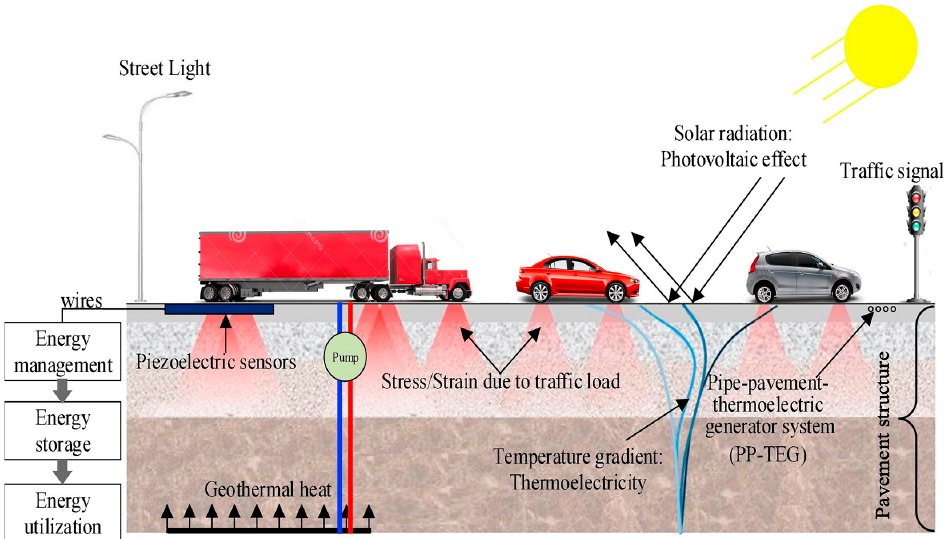
Figure 1. Available energy sources on a roadway (Reprinted with permission from Ref. [21]. 2018, Elsevier) [21]. Table 1. Comparison between different technologies for energy harvesting from